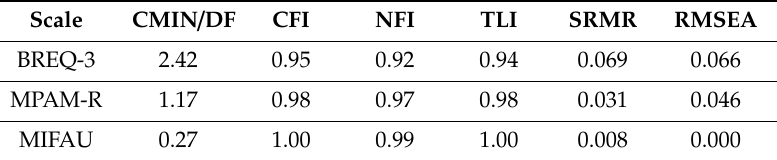
Table 1. Confirmatory factor analysis of all the